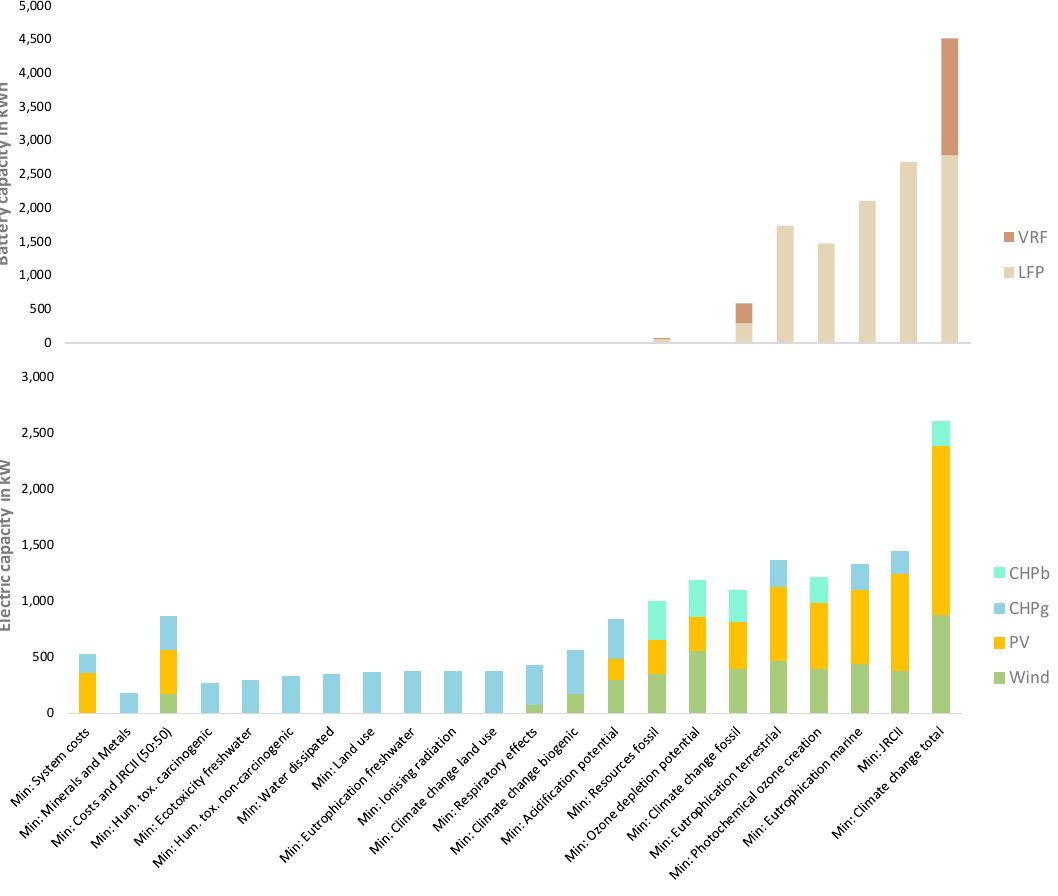
Figure 4. Total installed capacity from 2020 to 2050.